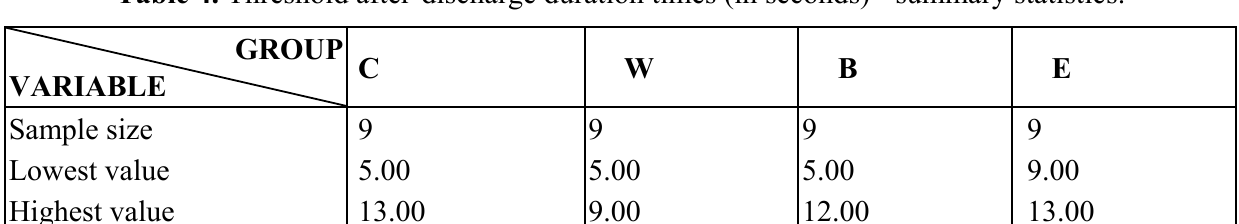
Table 4. Threshold after-discharge duration times (in seconds) - summary